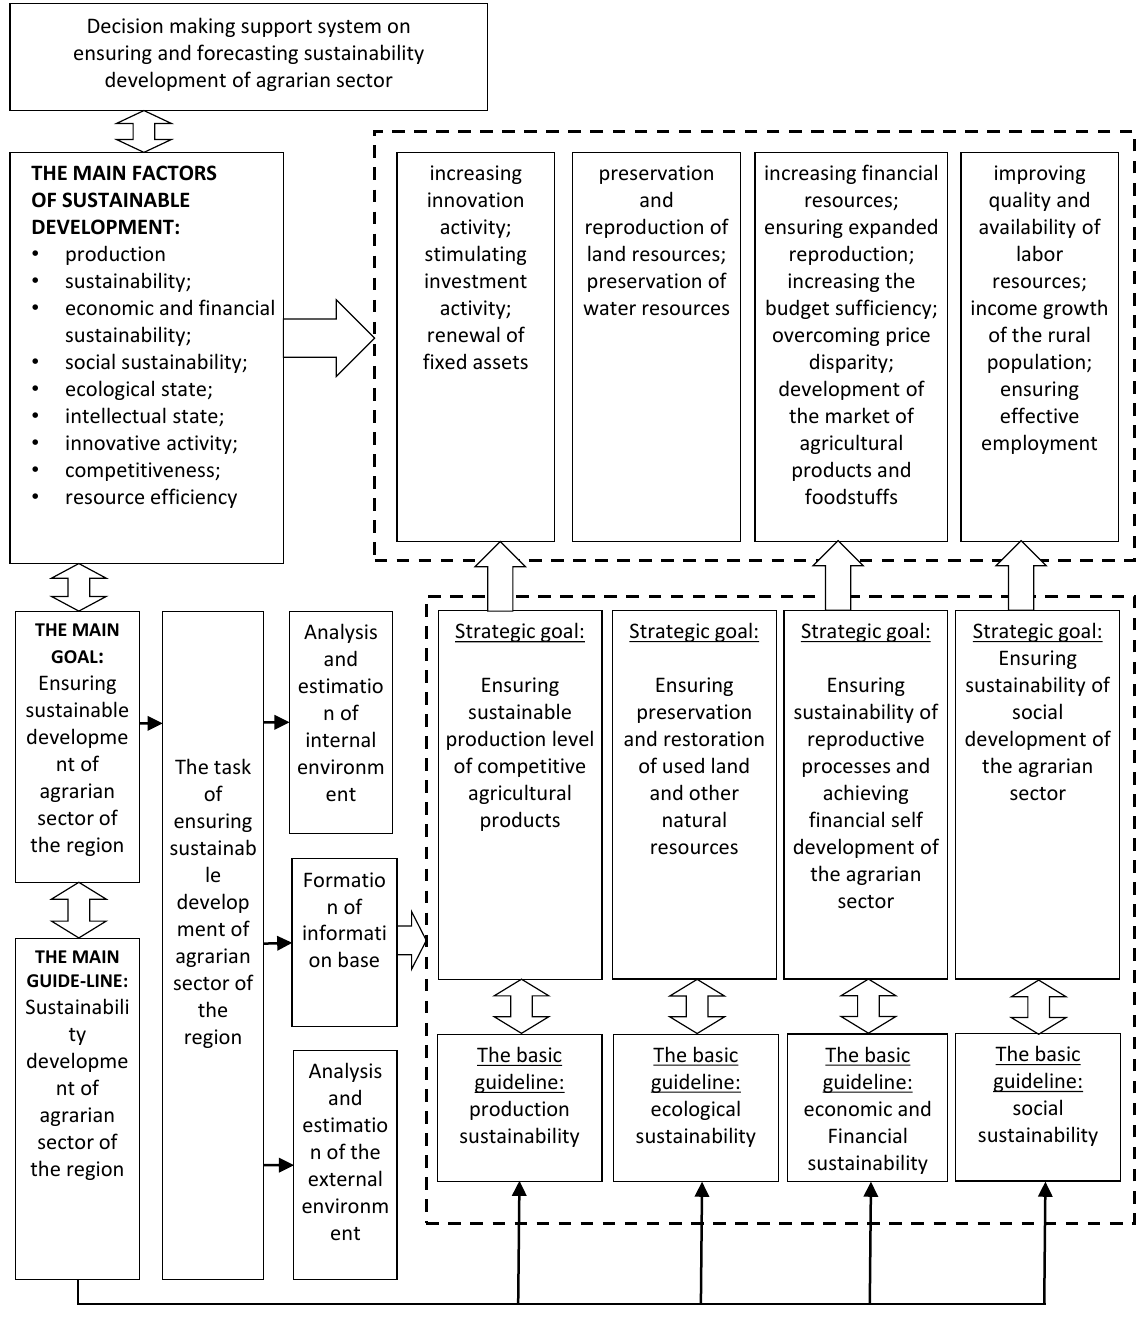
Figure 4. The target model of sustainable development of agrarian sector of Vinnytsya